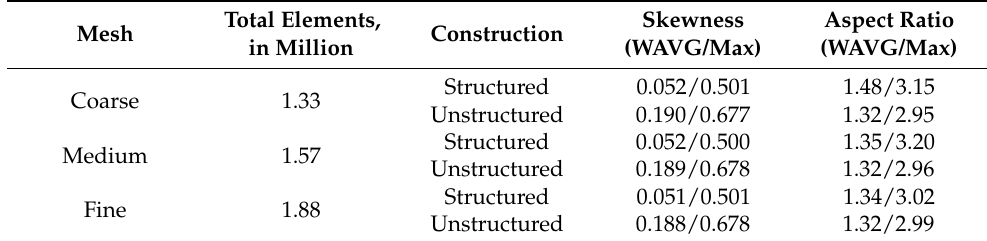
Table 2. Details of coarse, medium, and fine mesh.